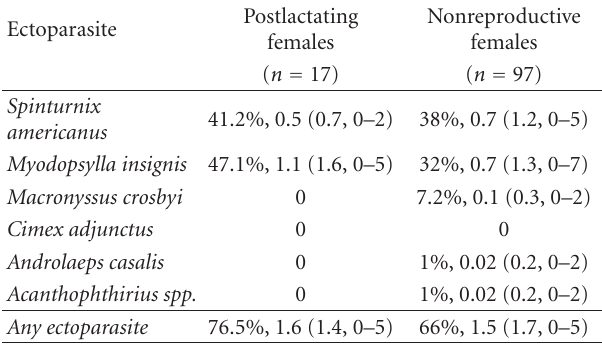
Table 4: Ectoparasite prevalence, mean intensity (standard devi- ation and range) on postlactating females versus nonreproductive females of both species of Myotis in Nova Scotia and New